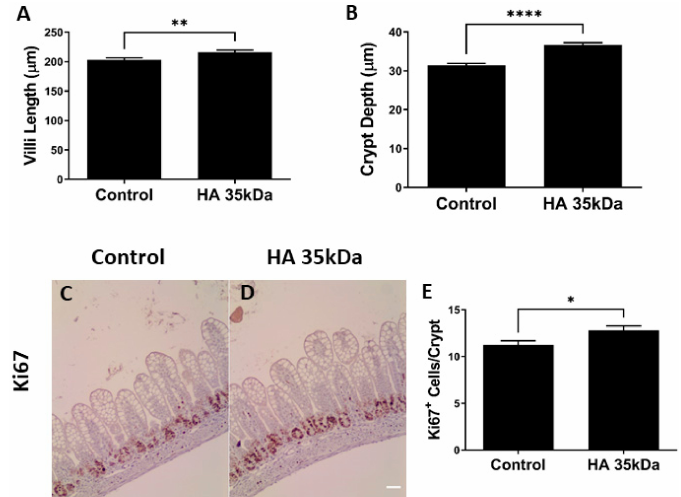
Figure 2. Oral HA 35 KDa supplementation from P7–P14 increases villi length ( A ) and crypt depth ( B ) in mouse pups ( n = 206 villi/crypts; p = 0.0085 (illi length) p < 0.0001 (crypt depth). A comparison of Ki67 staining (brown) of the ileum in controls ( C ) and HA 35 KDa ( D ) pups indicates increased intestinal epithelial proliferation with oral HA 35 KDa. Quantification ( n = 131 crypts; p = 0.0175) of Ki67 staining in ( E ). Data presented as mean ± SEM. HA: hyaluronic acid; * p < 0.05; ** p < 0.01; **** p < 0.0001.